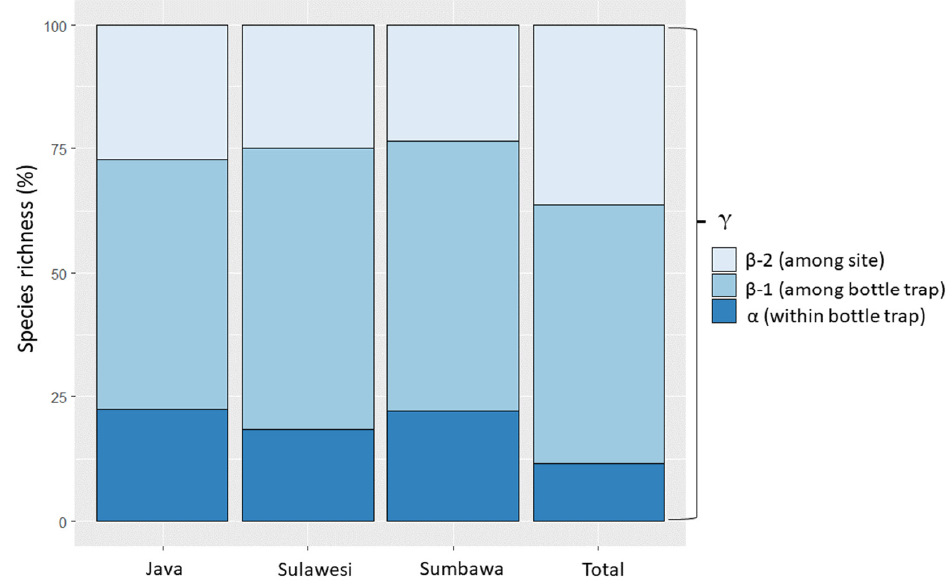
Figure 8. Additive diversity partitioning for the species richness of ambrosia beetles in the teak plantations in Java, Sumbawa, and Sulawesi Islands. Table 5. Overall and beta diversity ( β -sor ) partitioning in its spatial turnover ( β -sim ) and nestedness ( β -nes ) components based on multiple sites across the landscape (among sites within the island) and regional/island (among twelve sites)